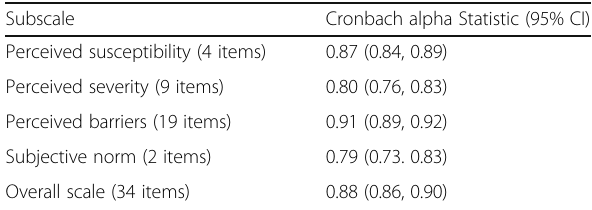
Table 7 Cronbach alpha of scales